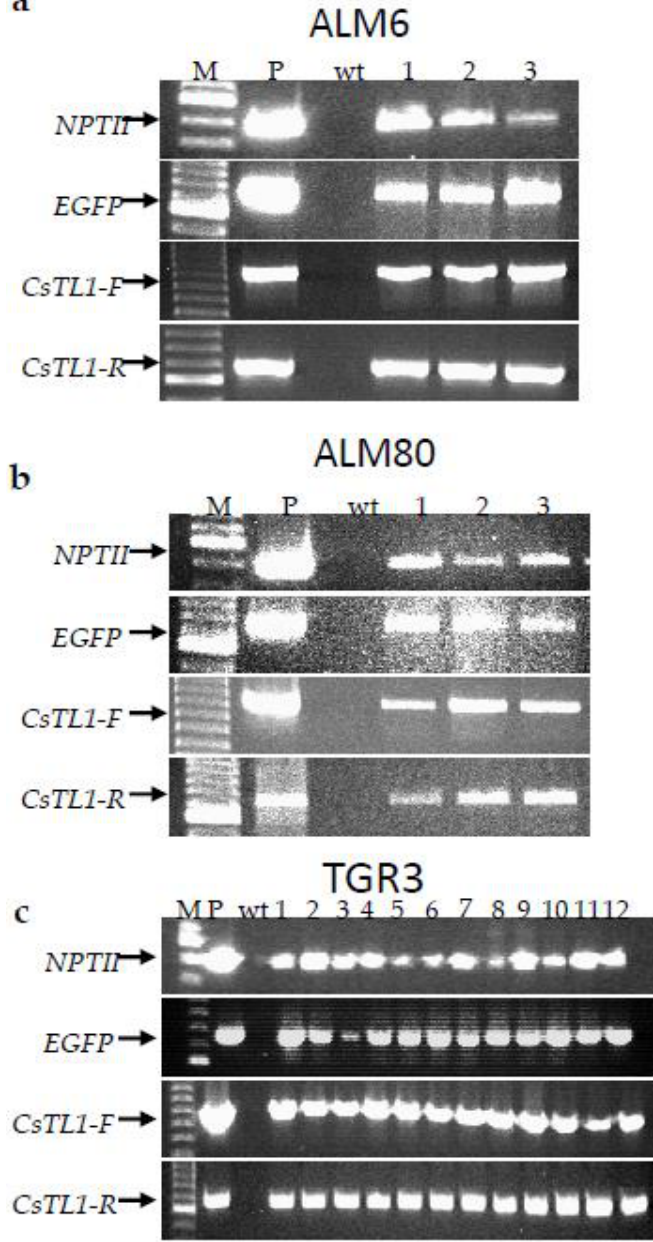
Figure 4. PCR analysis of transgenic lines to detect the presence CsTL1 (in both transcriptional senses), NPTII and GFP genes. M: Molecular ladder, ALM6 ( a ), ALM80 ( b ) and TGR3 ( c ). P: plas-mid (positive control), wt: non-transgenic somatic embryos of cork oak (negative control) and lanes 1–12: putative cork oak transgenic lines.